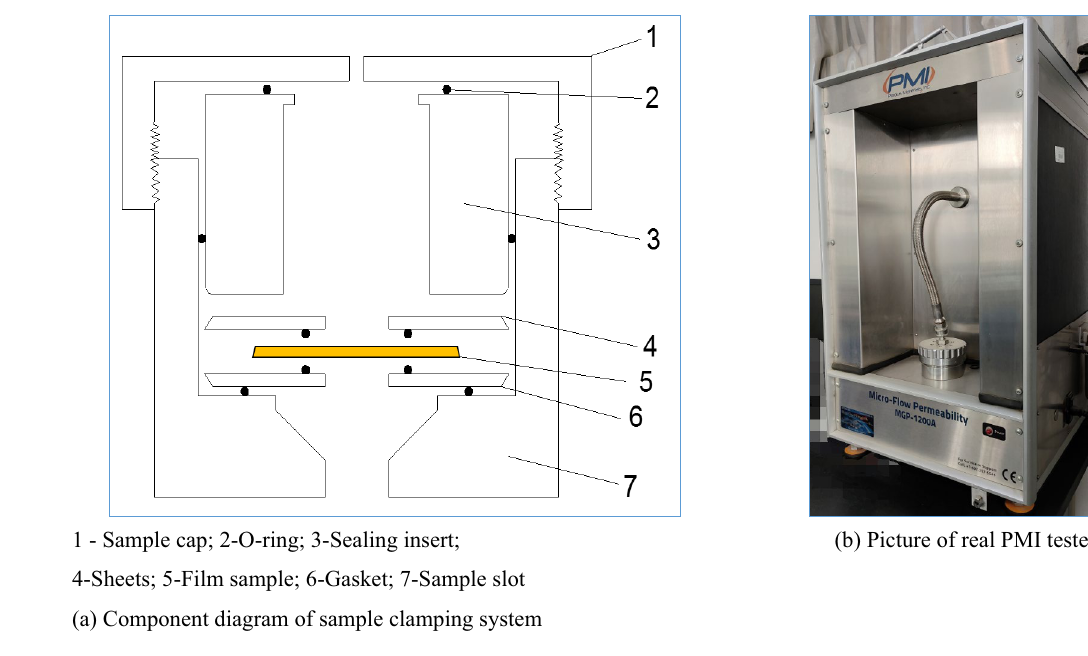
Fig. 4 PMI microflow permeability tester